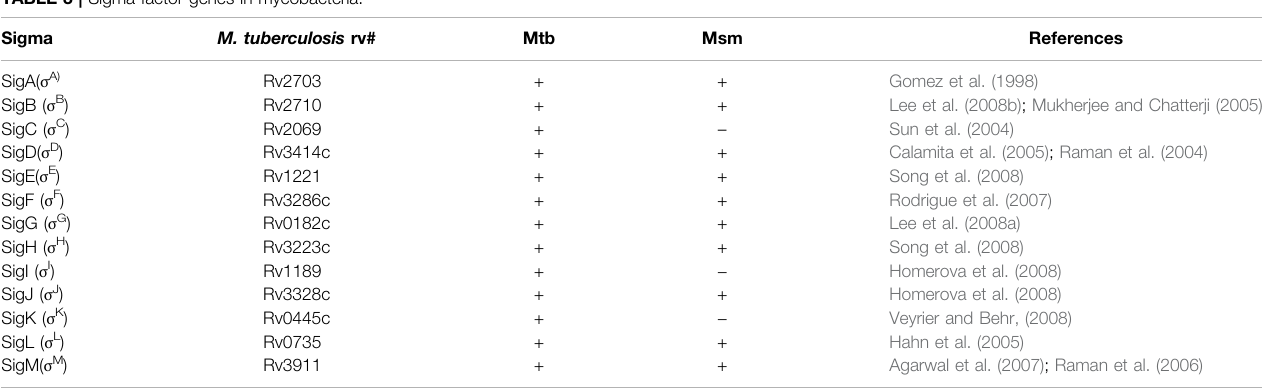
TABLE 3 | Sigma factor genes in mycobacteria.